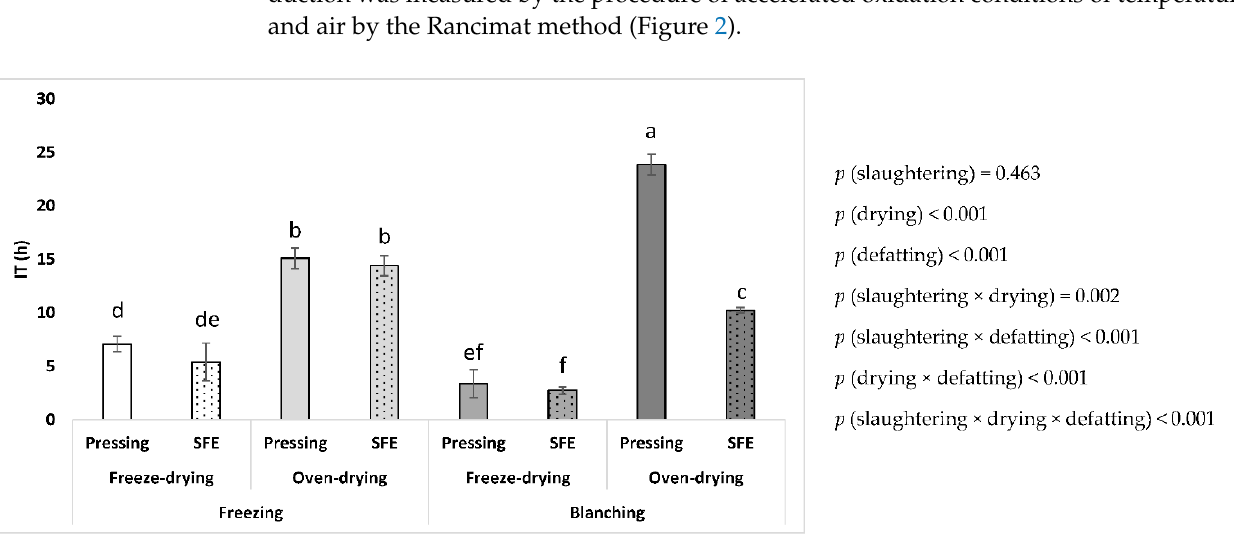
Figure 2. Oxidative stability (IT) by the accelerated Rancimat method of the fat from BSFL processed by different methods of slaughtering, drying, and defatting. Different letters between the treatments mean significant differences. Each data point corresponds to mean values ± SD, n = 4.